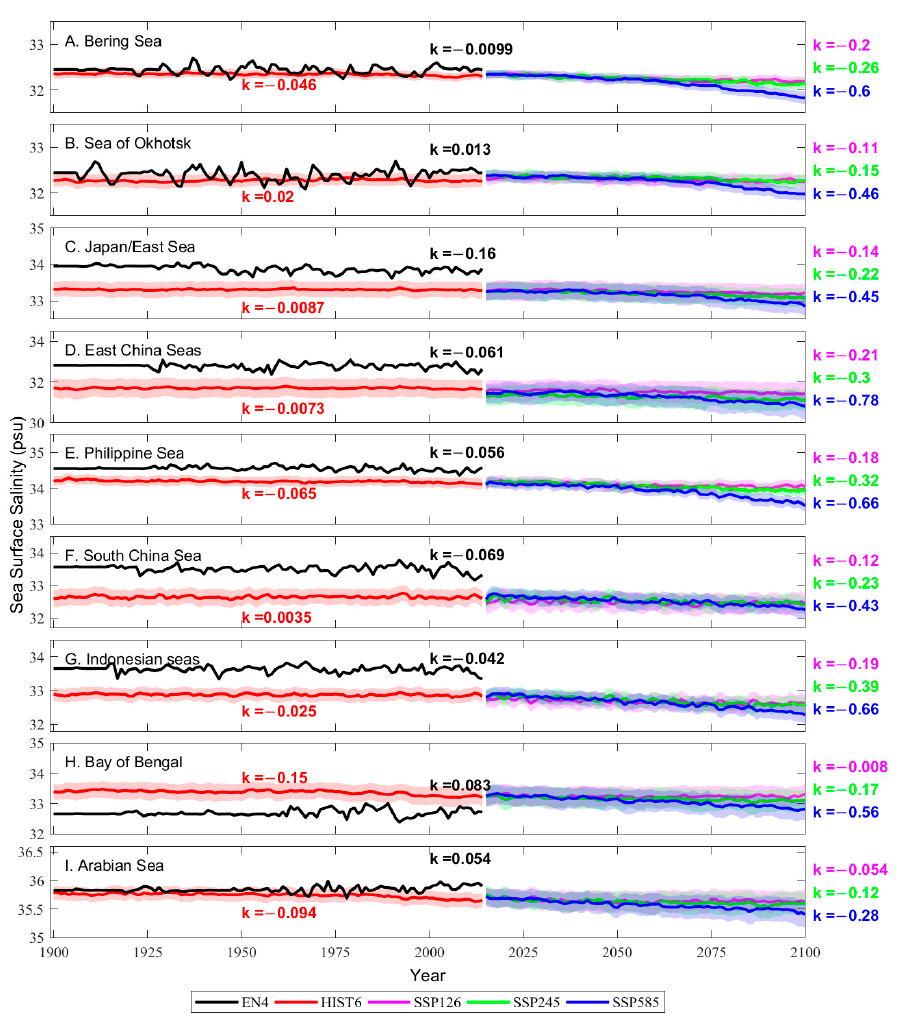
Figure 8. Spatial mean time series of sea surface salinity (SSS; unit: psu) from observation (black), multi-model ensemble means (MME) of the CMIP6 historical simulation (red), and MME of the simulations under SSP126 (pink), SSP245 (green), and SSP585 (blue), with the uncertainty between the models (shaded) for the Asian Marginal Seas (AMSs) in January. The “k” means the SST trend for historical (1900–2014) or future (2015–2100) period (unit: psu/century), and different colors of “k” correspond to the colorful line.